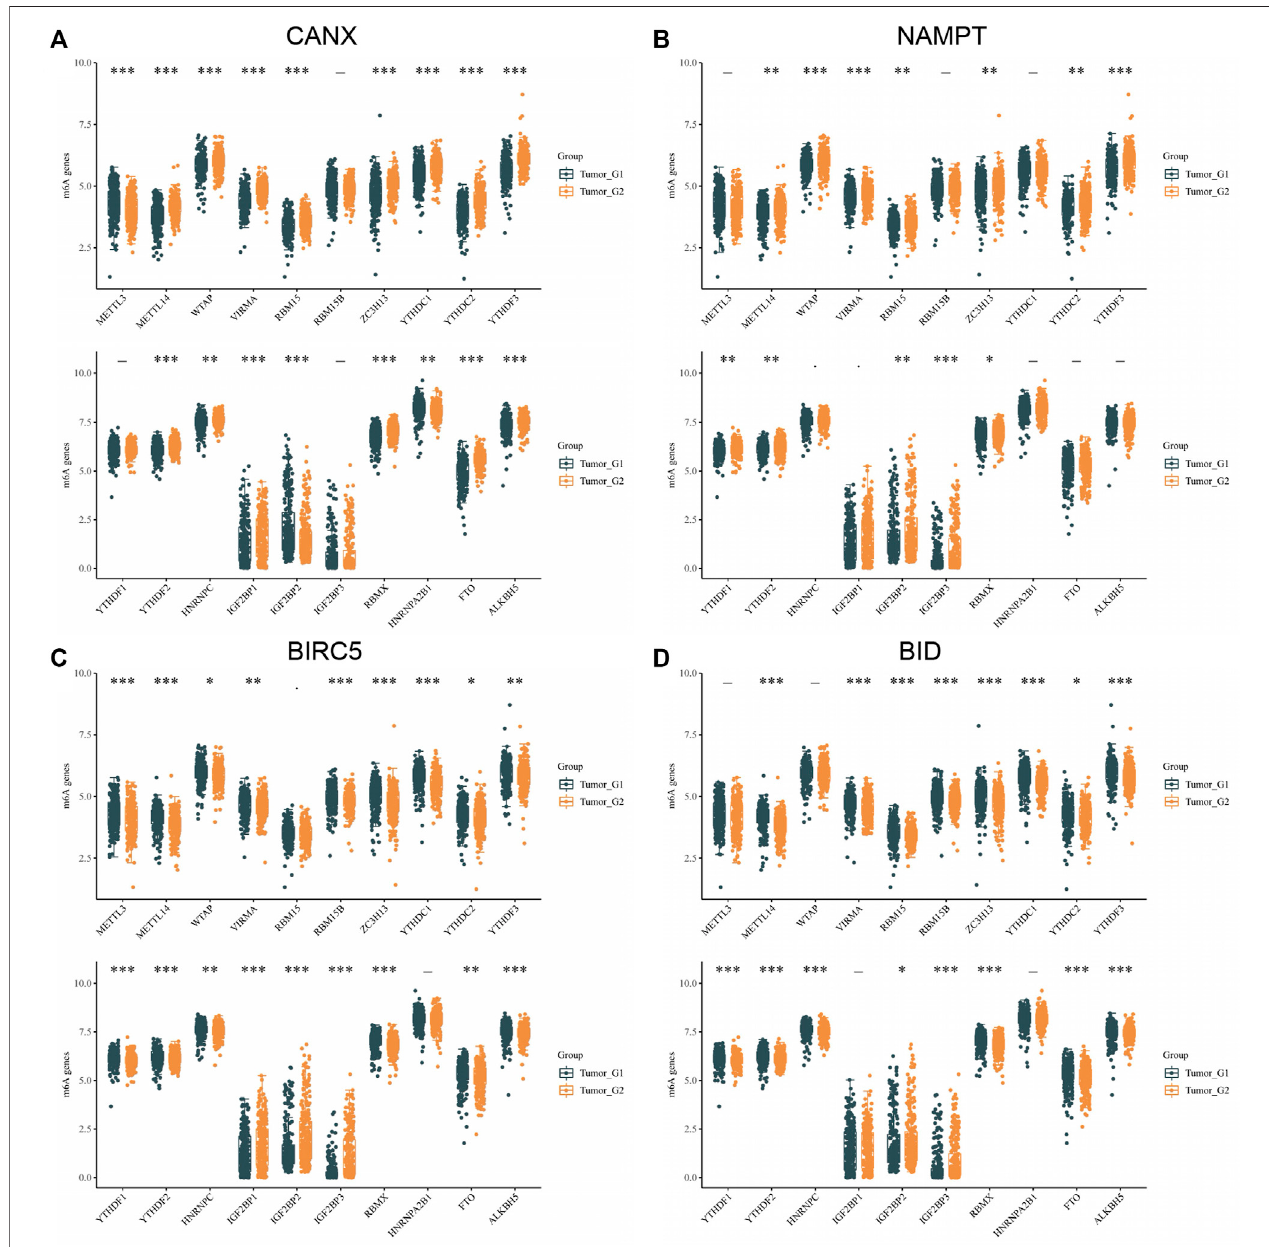
FIGURE 10 | Correlation between m 6 A methylation-related genes and immune-autophagy-related differentially expressed genes (DEGs). The difference of expression ofmethylationofm 6 Arelatedgenesinkidneyrenalclearcellcarcinoma (KIRC)tissueswithhighandlowCANX (A) ,NAMPT (B) ,BIRC5 (C) ,andBID (D) gene expression. G1 is a low-expression group, and G2 is a high-expression